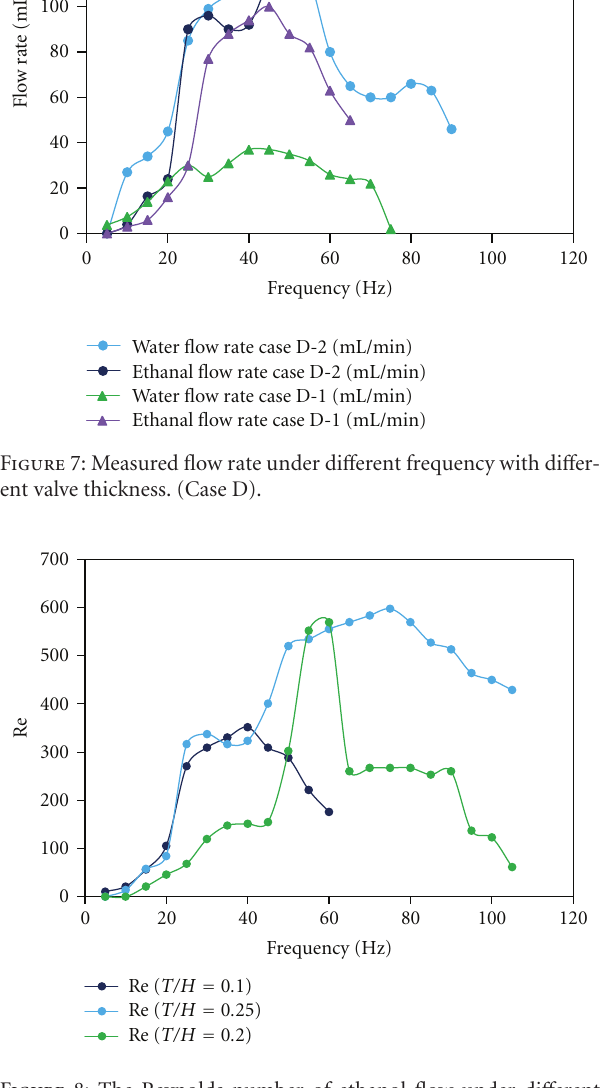
Figure 8: The Reynolds number of ethanol flow under di ff erent T/H ratios.